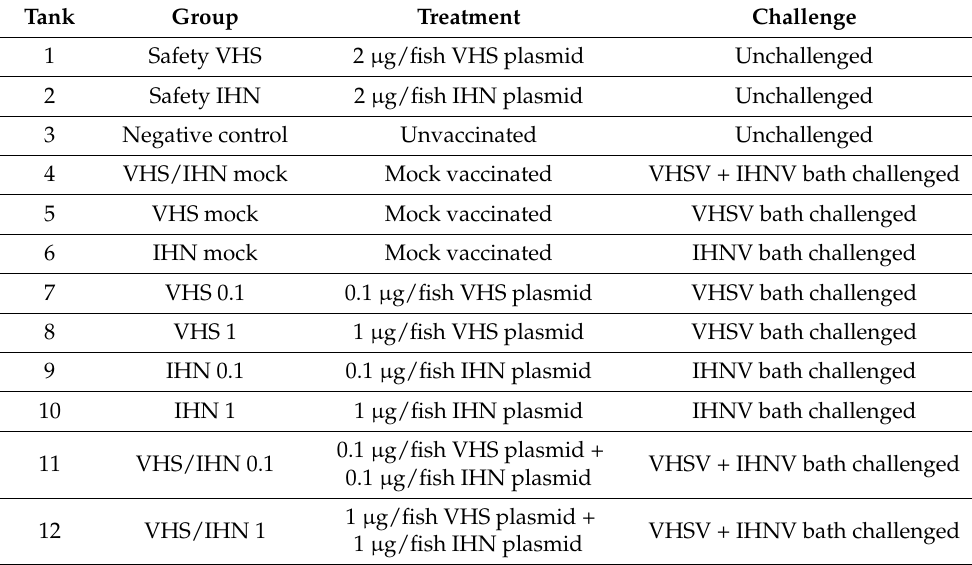
Table 2. Controlled condition experimental